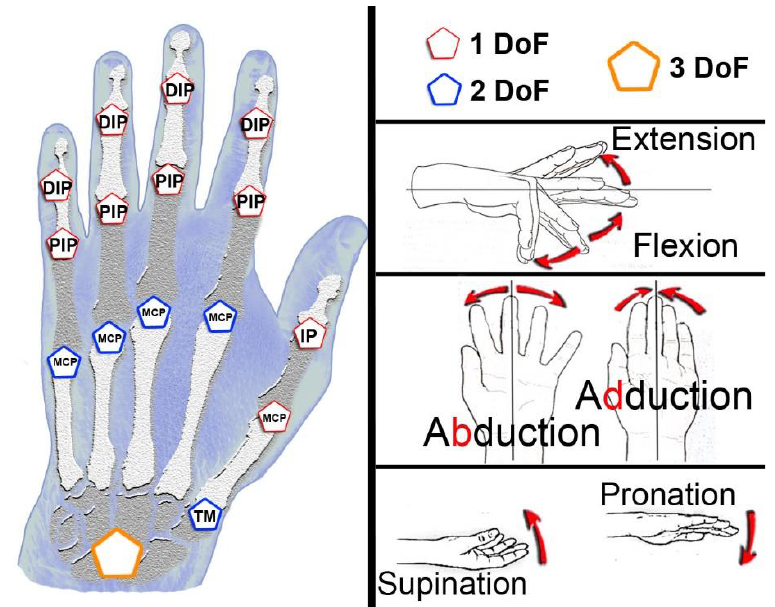
Figure 1. Representation of degrees of freedom in wrist and fingers.